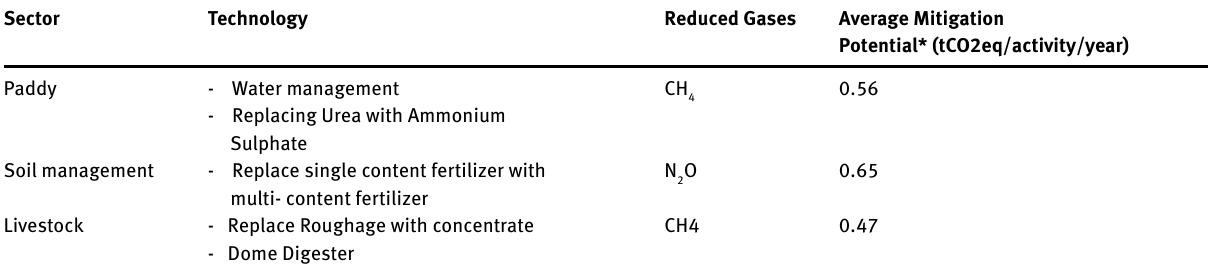
Table 2: Mitigation Technology and Mitigation Potential Sector